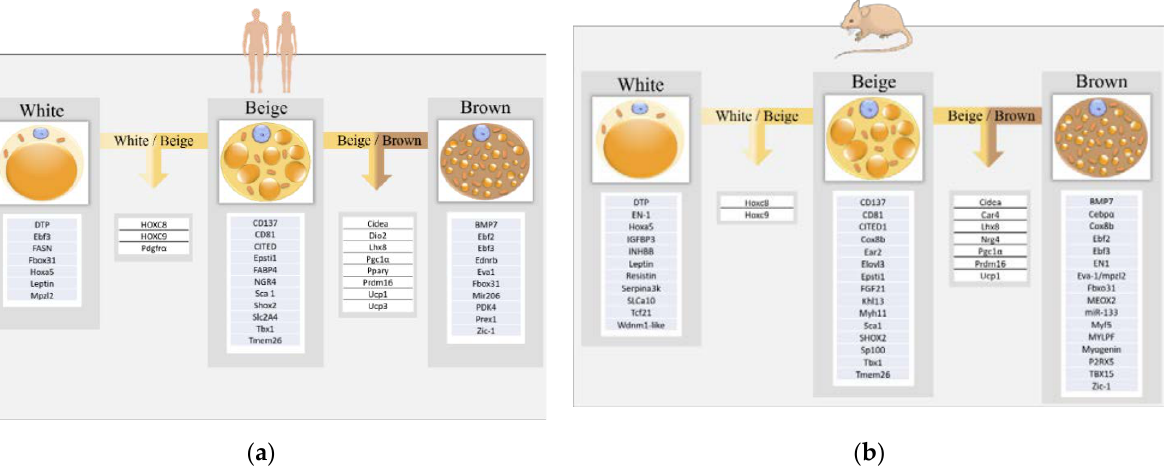
Figure 2. White, Beige and Brown adipocyte markers in Human and Mouse. We summed up here genes reported in the literature as markers of white (WAT), beige and brown adipose tissues (BAT) and shared by beige and WAT or beige and BAT in humans ( a ) and mice ( b